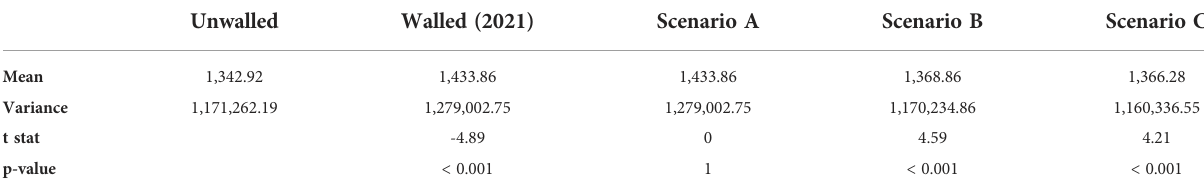
TABLE 1 Results of t-test comparing energy expenditures (kcal) for jaguar, unwalled and walled 2021 and t-tests comparing remediation scenarios A, B, and C to walled